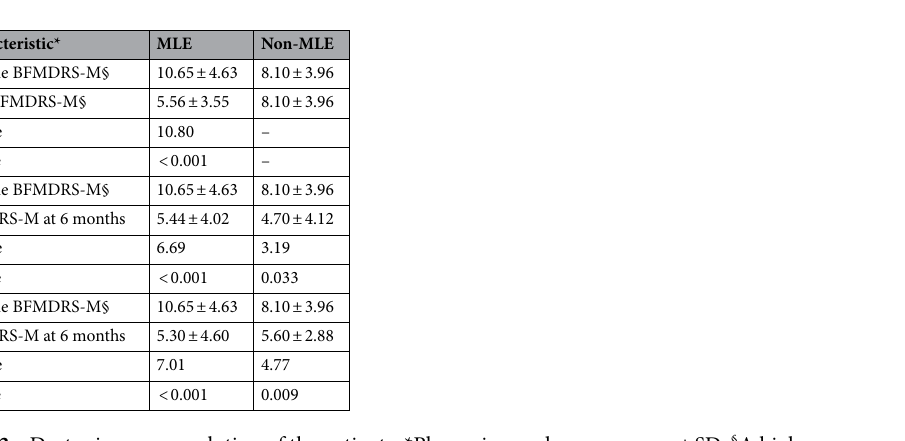
Table 3. Dystonia scores evolution of the patients. *Plus–minus values are means ± SD. § A higher score indicates worse